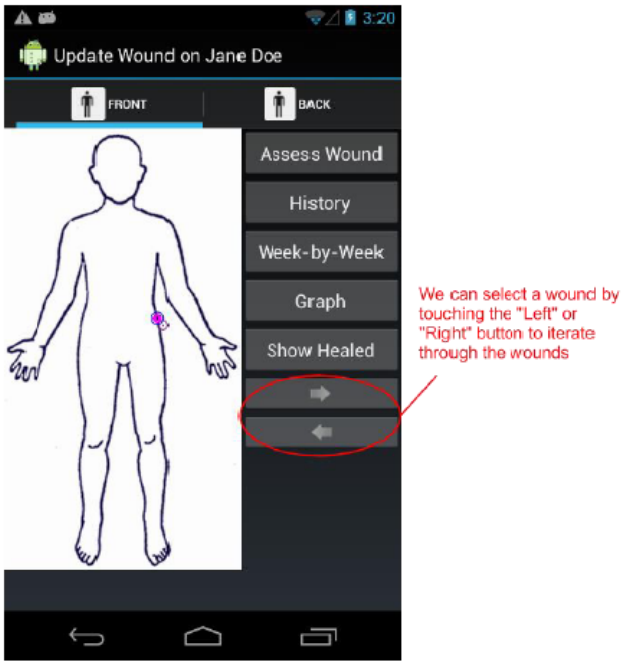
Figure 4. The Update Wound Assessment screen. We can select wounds by either using the cursor on the patient image, or by tapping the “Left” and “Right” buttons. Once a wound is selected, we may reassess the wound, view its history, compare the last two assessment forms, or view graphically view all of its assessment